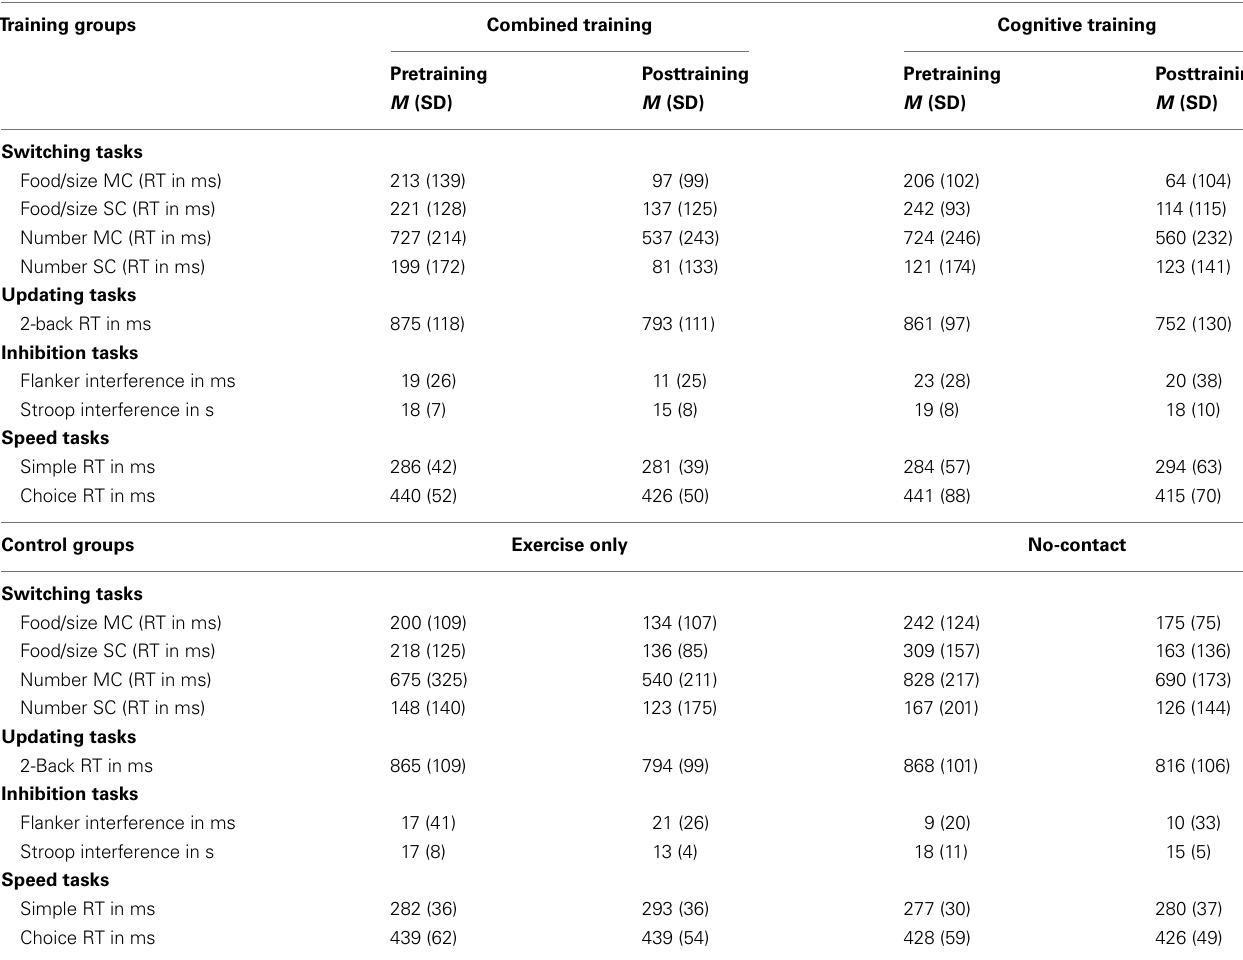
Table 3 | Performance on main dependent RT measures in transfer tasks in the training groups (combined and cognitive training only) and control groups (exercise only and